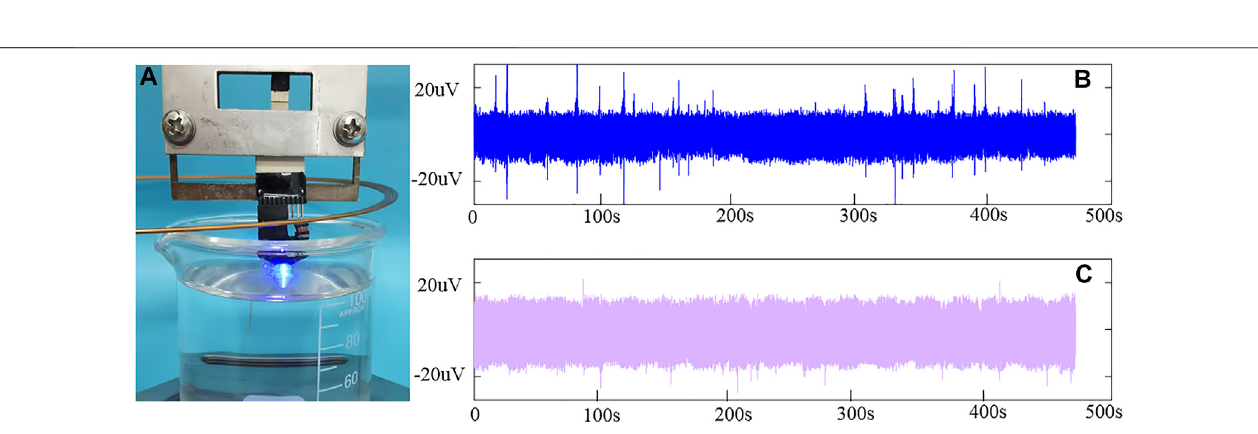
FIGURE 7 | Noise test of the optrode (A) Picture of the optrode on (B) Bottom noise when the optrode is off (C) Bottom noise when the optrode is on.